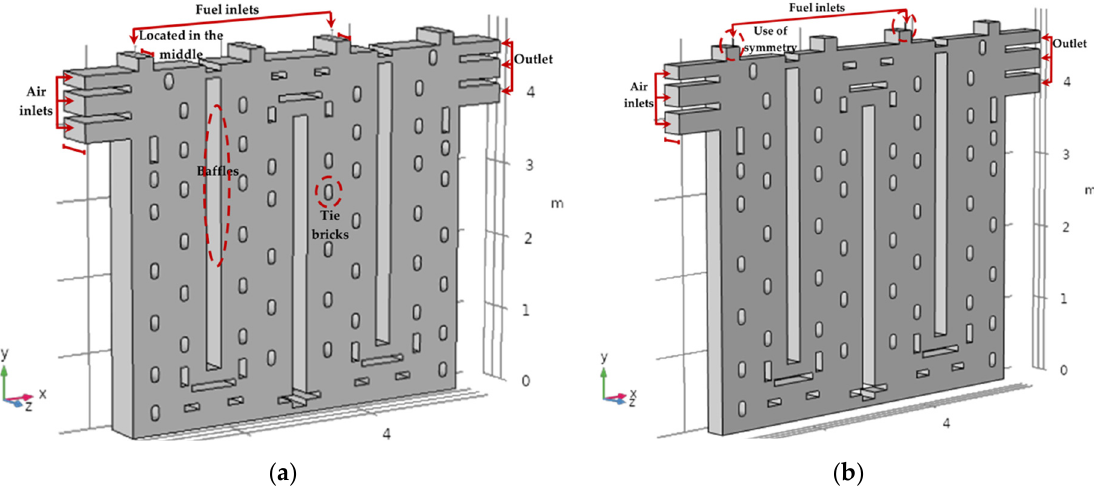
Figure 1. Illustration of the two geometries used for representing the z-component of the single section of an anode baking furnace (ABF). ( a ) Geometry 1: a full representation of the z -axis; ( b ) Geometry 2: a half representation of the z -axis.